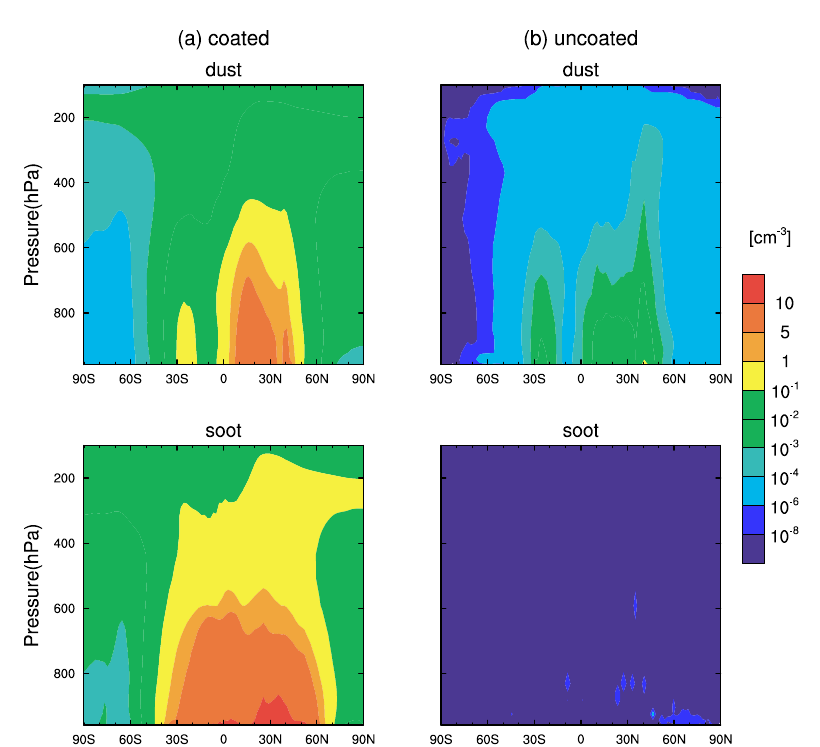
Figure 4. Zonal and annual mean number concentrations of (a) interstitial coated and (b) interstitial uncoated mineral dust (upper) and soot particles